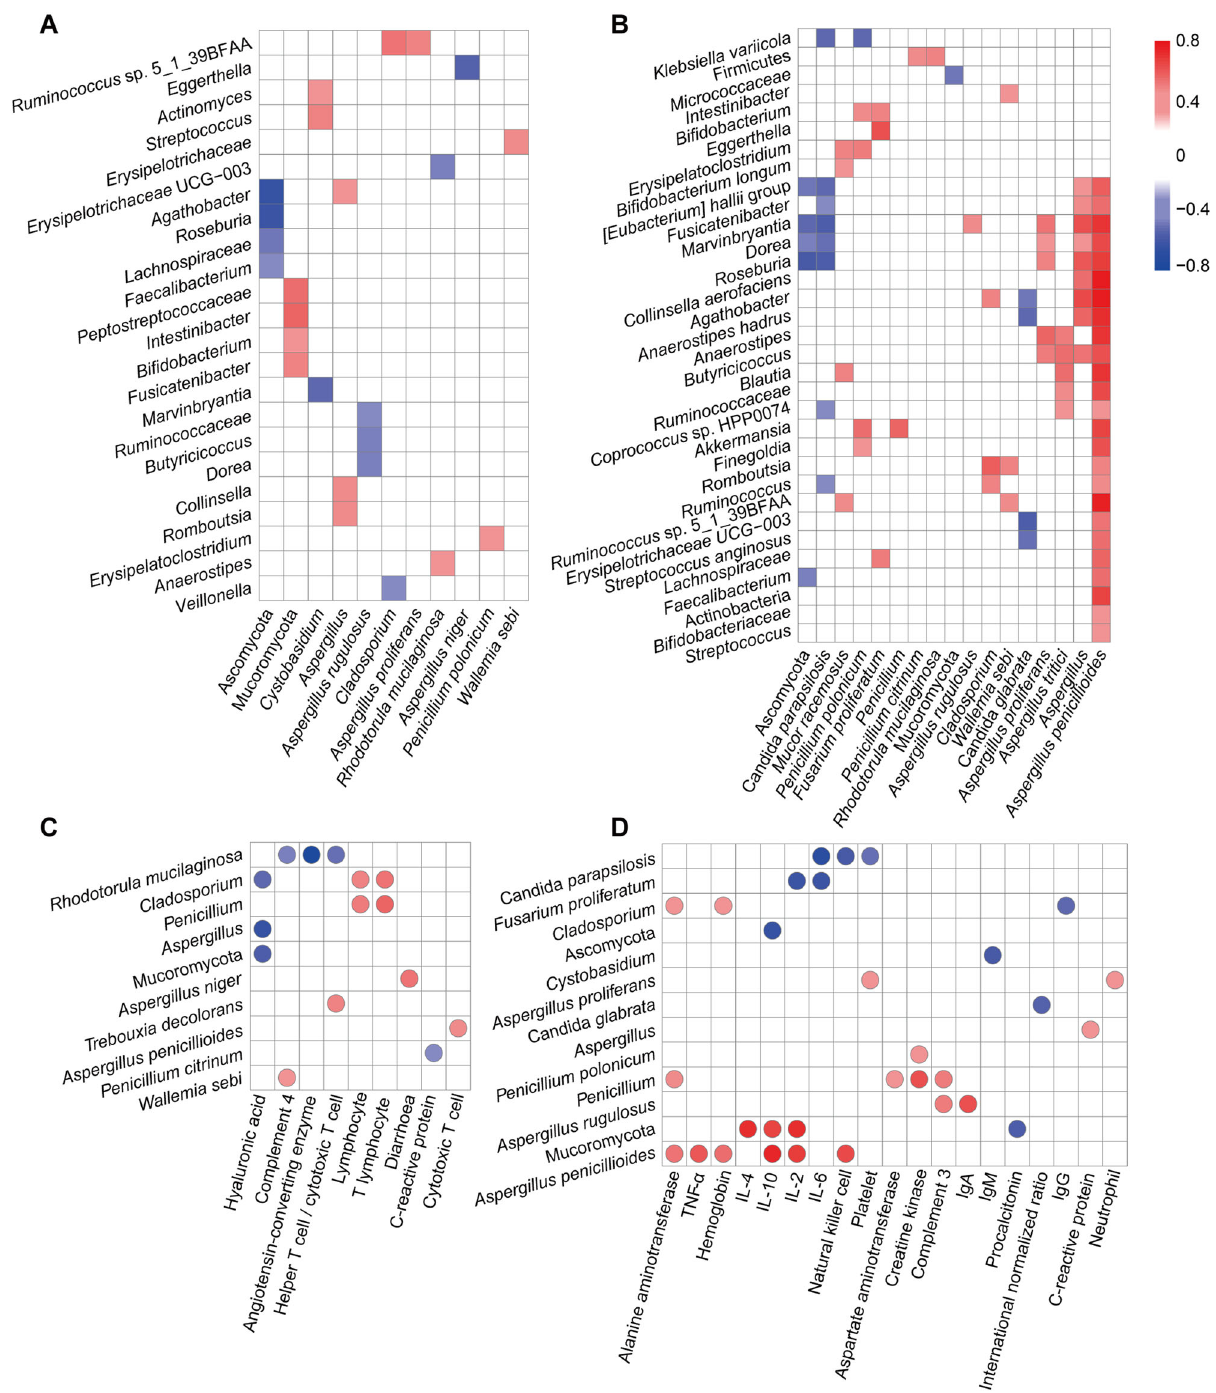
Fig. 5 Altered gut fungal taxa are strongly linked with gut bacterial taxa and blood in fl ammatory, liver, infectious and metabolic biomarkers. Spearman correlations of signi fi cantly altered gut mycobiota with signi fi cantly altered gut microbiota in ( A ) COVID-19 patients or ( B ) H1N1-infected patients. Spearman correlations of signi fi cantly altered gut mycobiota with signi fi cantly altered blood biomarkers in ( C ) COVID-19 patients or ( D ) H1N1-infected patients. Only correlations with a P < 0.05 and a correlation coef fi cient >0.4 or < − 0.4 are